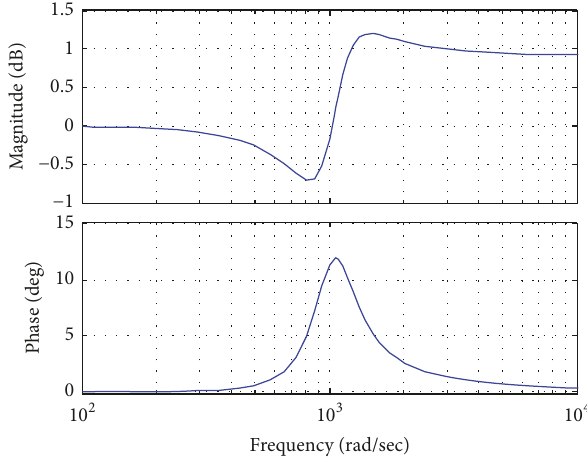
Figure 2: Bode diagram of resonance